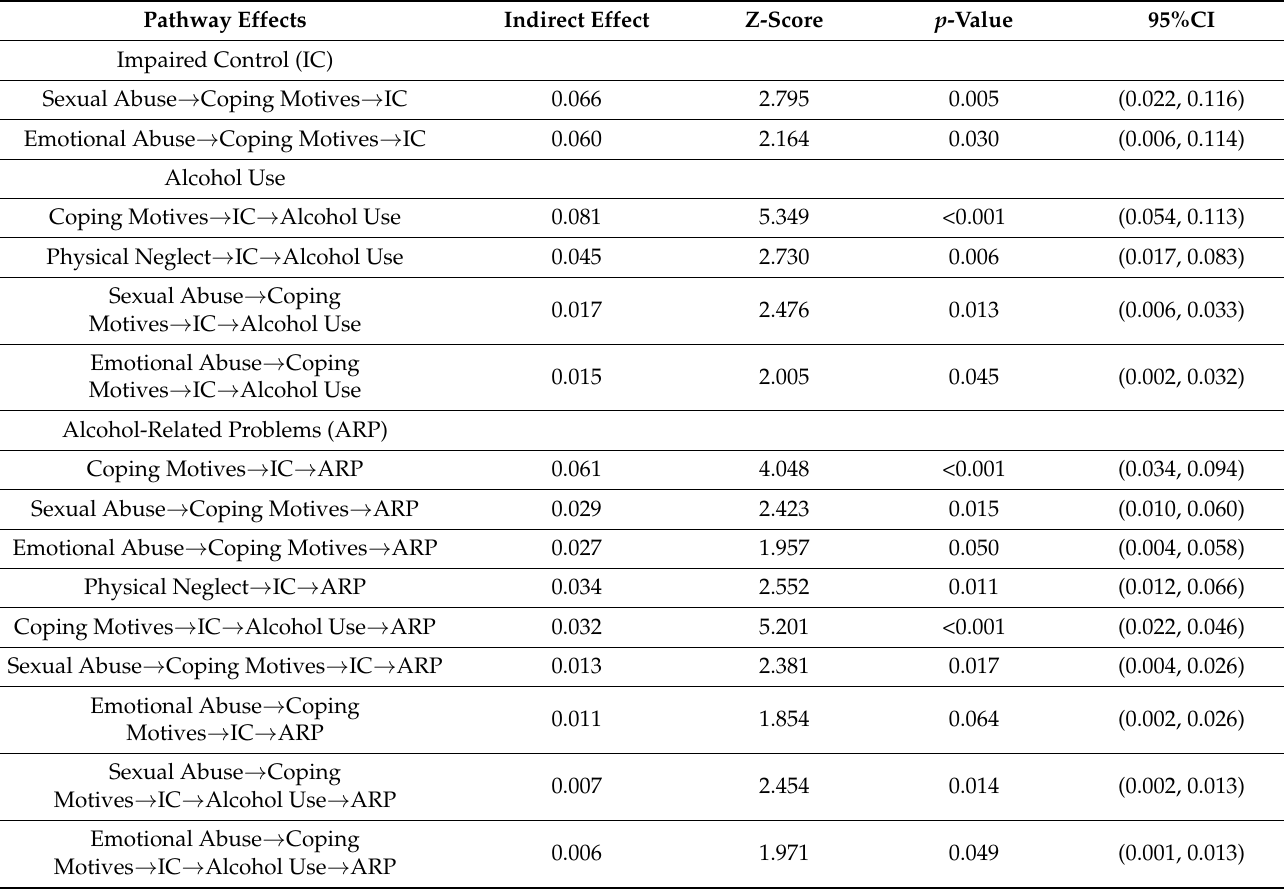
Figure 2. Fit path model for 612 university students. Standardized coefficients are shown with all exogenous variables allowed to correlate freely in the model. Women were coded as zeros, while men were coded as ones. Hence, a positive relationship between gender and alcohol use means that being a man was associated with more alcohol use. ** p < 0.01; *** p < 0.001. Table 3. Mediated